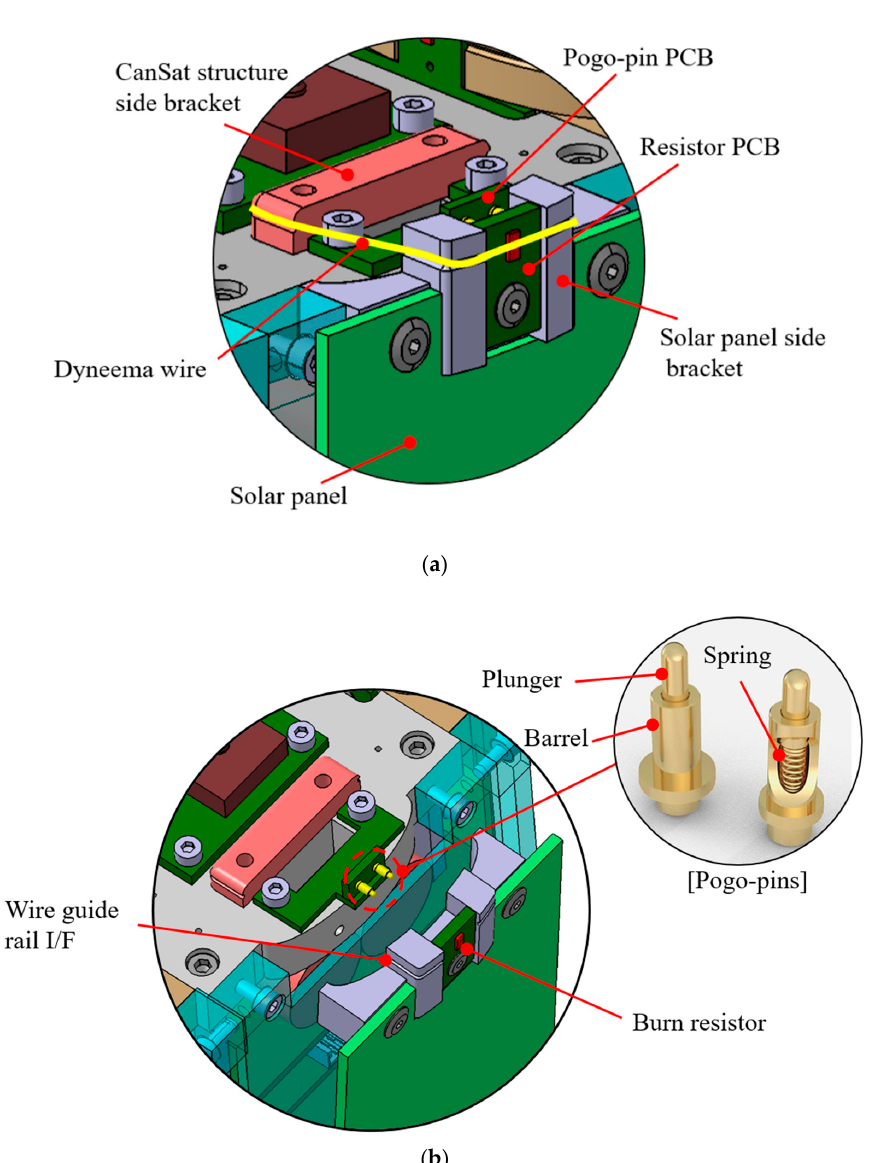
Figure 4. Close-up views of the pogo pin-type HRM: ( a ) fully stowed solar panel, and ( b ) partially deployed solar panel.